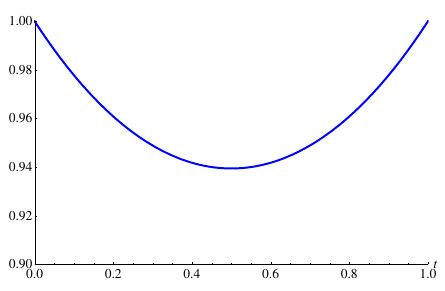
Figure 11 . Two-point function of U(1) theory in units where (cid:12) =